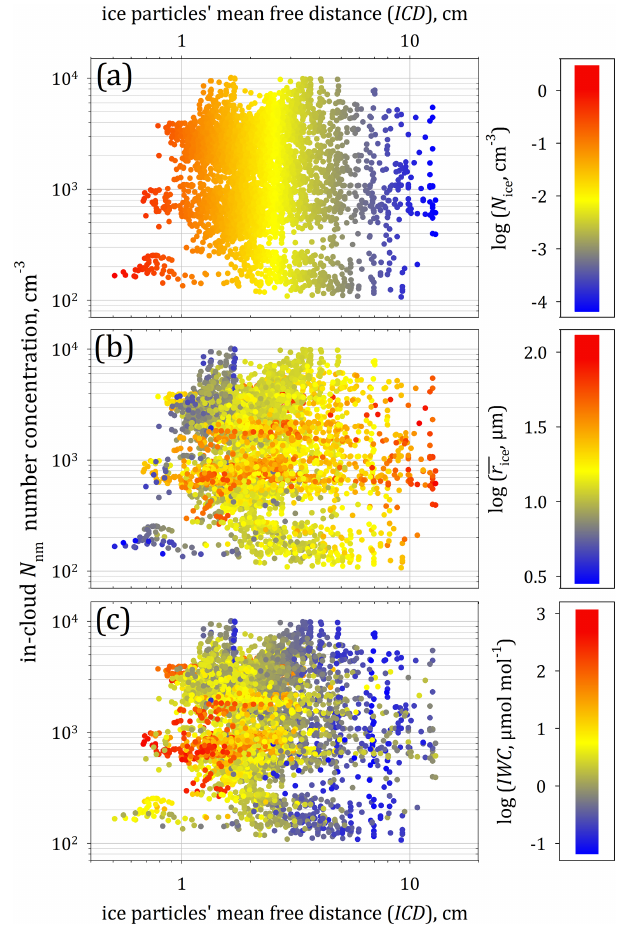
Figure 7. Concentrations of in-cloud-detected nucleation-mode aerosols ( N nm ) in 1Hz resolution as a function of the mean inter- crystal distance, ICD, between encountered cloud (ice) particles colour-coded with reference (a) to the number concentration of cloud ice particles, (b) to the IWC, and (c) to the mean ice parti- cles’